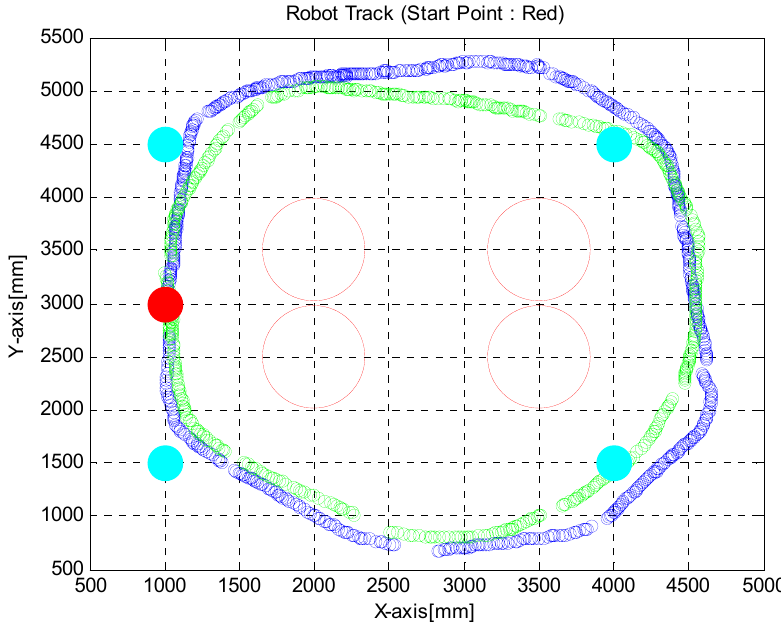
Figure 14. Robot track acquired from the third test.